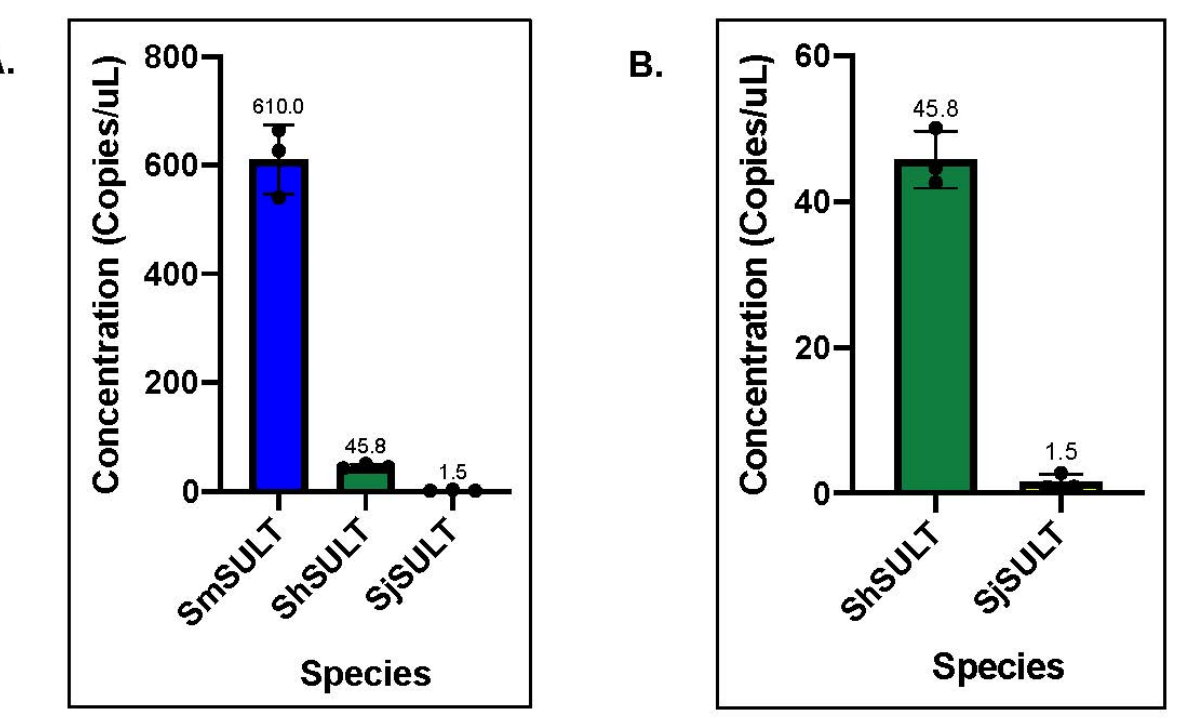
Figure 9. Comparison of concentrations (copies/µL) of sulfotransferase transcripts across all three Schistosoma species. ( A ) Mean concentration of SmSULT (610 copies/µL), ShSULT (45.77 copies/µL), and SjSULT (1.533 copies/ µ L) per well. ( B ) Concentration of ShSULT and SjSULT for closer comparison. Based on 3 individual experiments. Std. Deviation: Sm = 63.53, Sh = 3.48; Sj = 1.097.